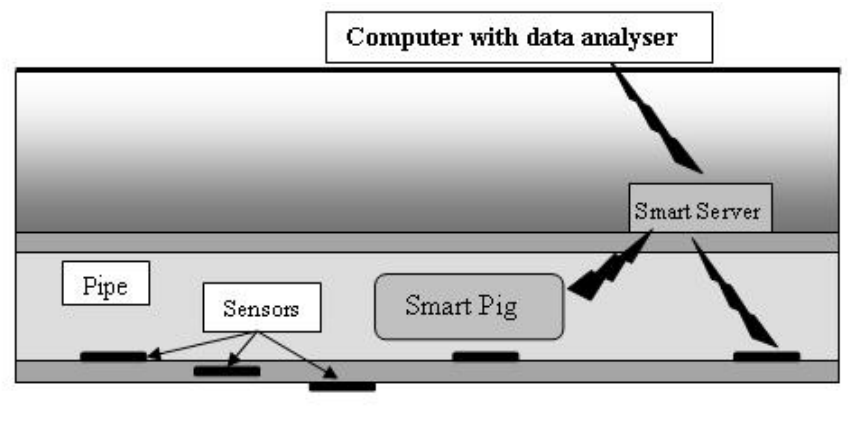
Figure 5. Schematic arrangement of possible Smart Pipe systems involving a Smart Pig and Smart Server arrangement, and a Smart Server and sensors.